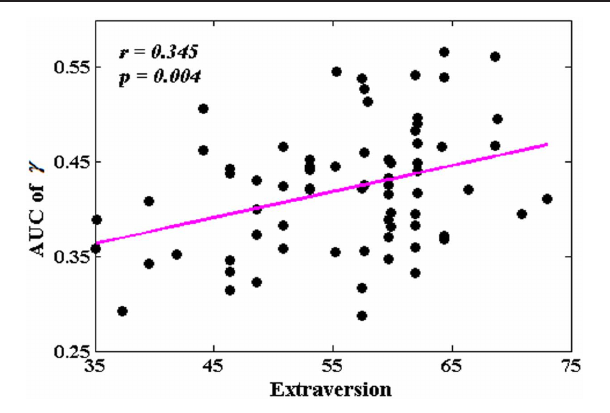
FIGURE 1 | The correlation between the area under the curve (AUC) of γ and extraversion scores ( p < 1 . 90). AUC was calculated over the range of 0 . 1 ≤ T ≤ 0 . 31 with an interval